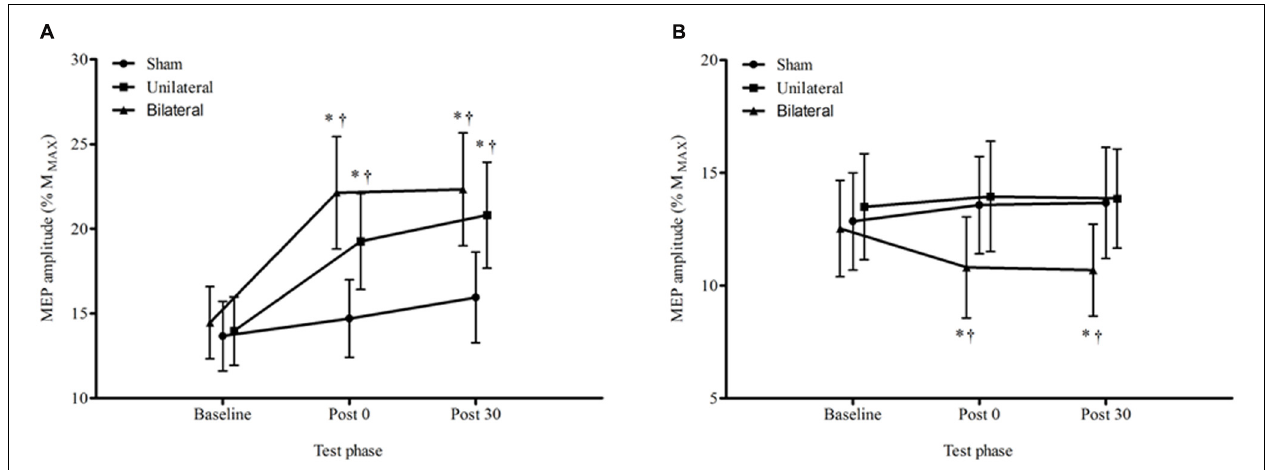
FIGURE 3 |Average ± SEM MEP amplitudes (% of M MAX ) at 130%AMT for all conditions across all time points . (A) non dominant M1, (B) dominant M1. ∗ p < 0.05 compared to baseline. † p < 0.05 compared with sham.